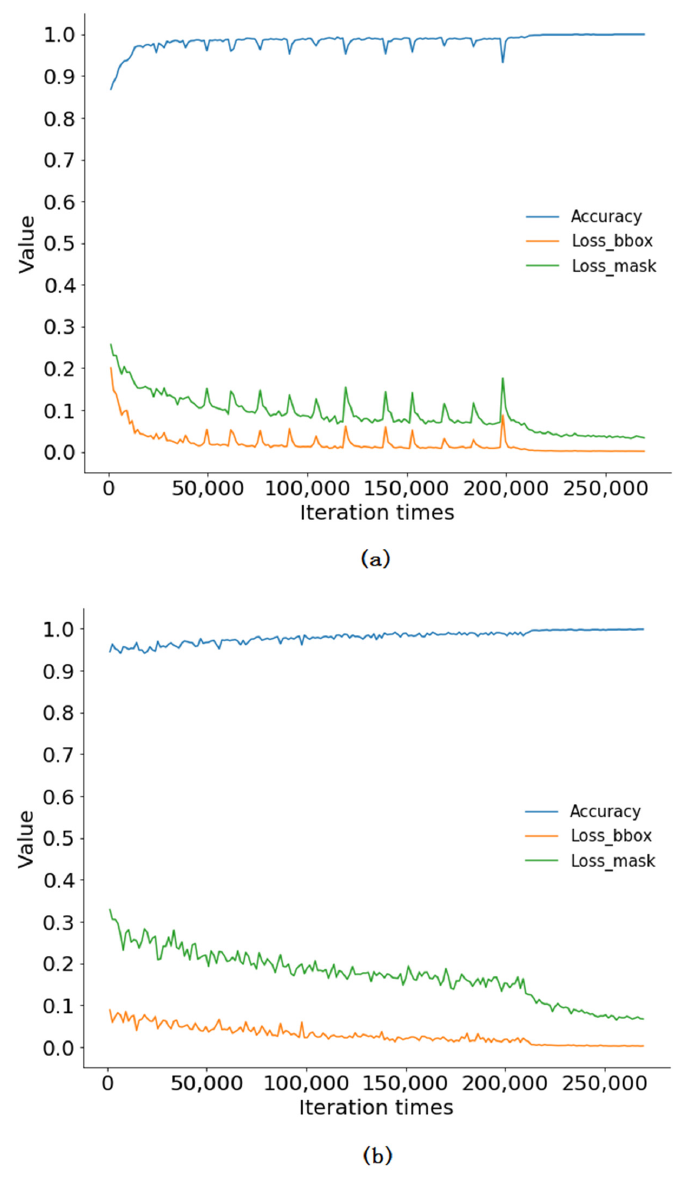
Figure 3. A flowchart of the proposed approach for evaluating FHB disease severity. Figure 4. Training curves of accuracy and loss against number of iterations on identifications of ( a ) wheat spikes and ( b ) diseased